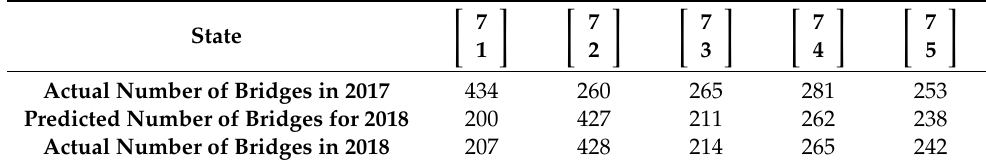
Table 3. Actual and predicted number of bridges in states (cid:3427) (cid:2875)